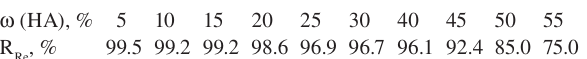
Table 1 The effect of concentration of higher alcohols (HA) on the extraction of rhenium (VII).